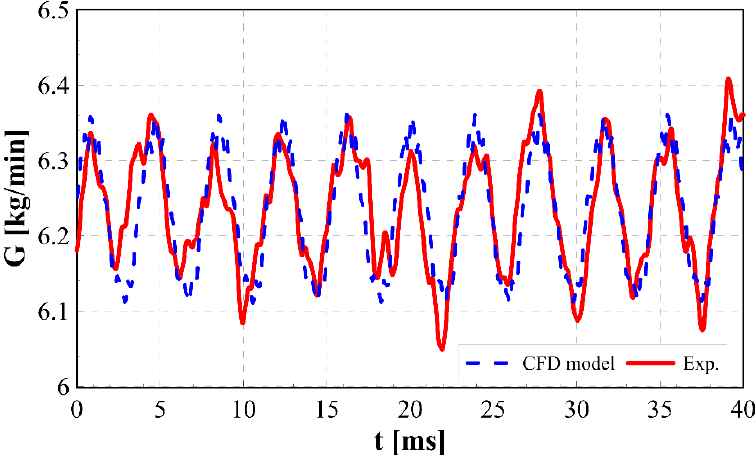
Figure 9. Comparison between the numerical and the experimental flowrates (1200 rpm, 4 bar— Configuration 1).